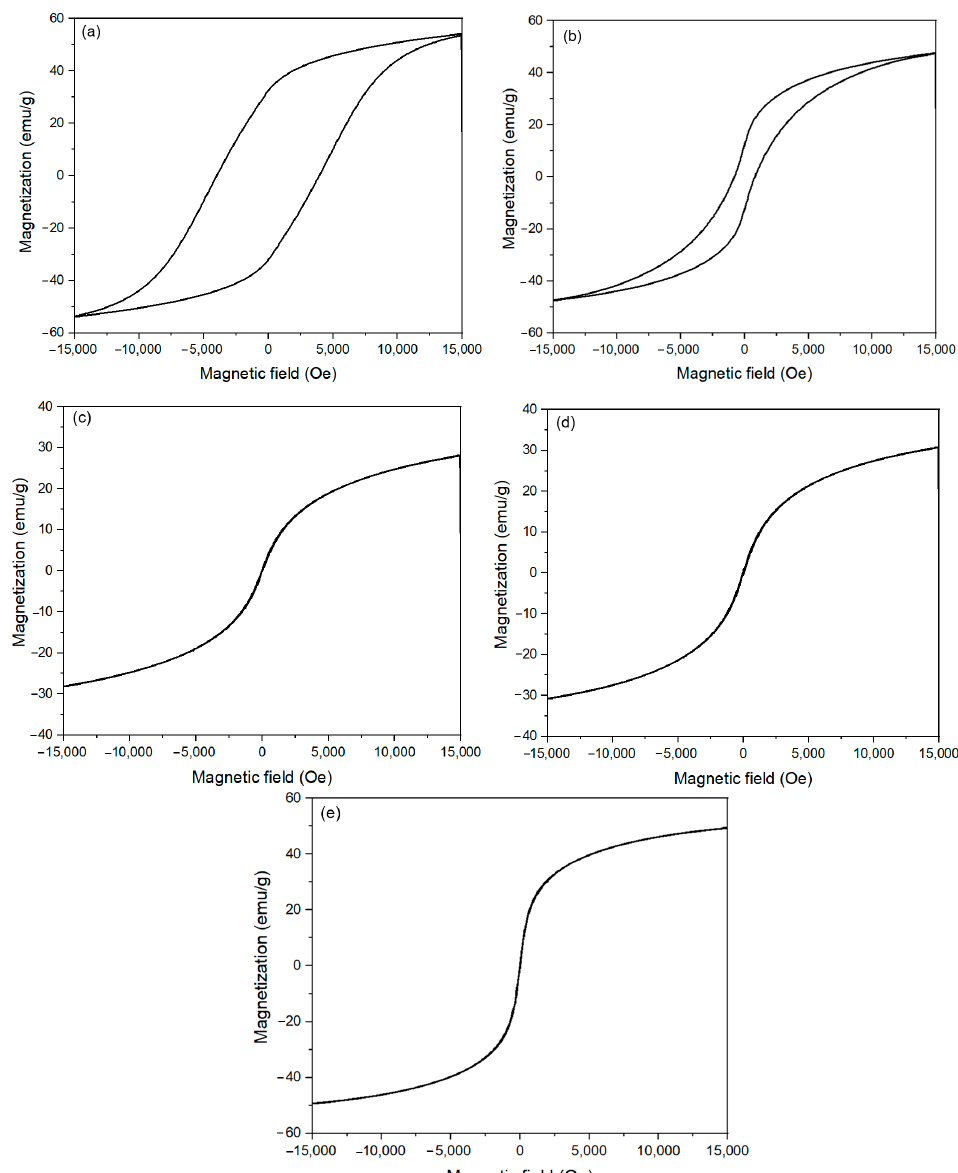
Figure 13. Room temperature M vs. H dependence of CoFe 2 O 4 nanoparticles synthesized with different oleic acid concentrations, 0 M ( a ), 0.05 M ( b ), 0.1 M ( c ), 0.15 M ( d ), and 1 M ( e ).